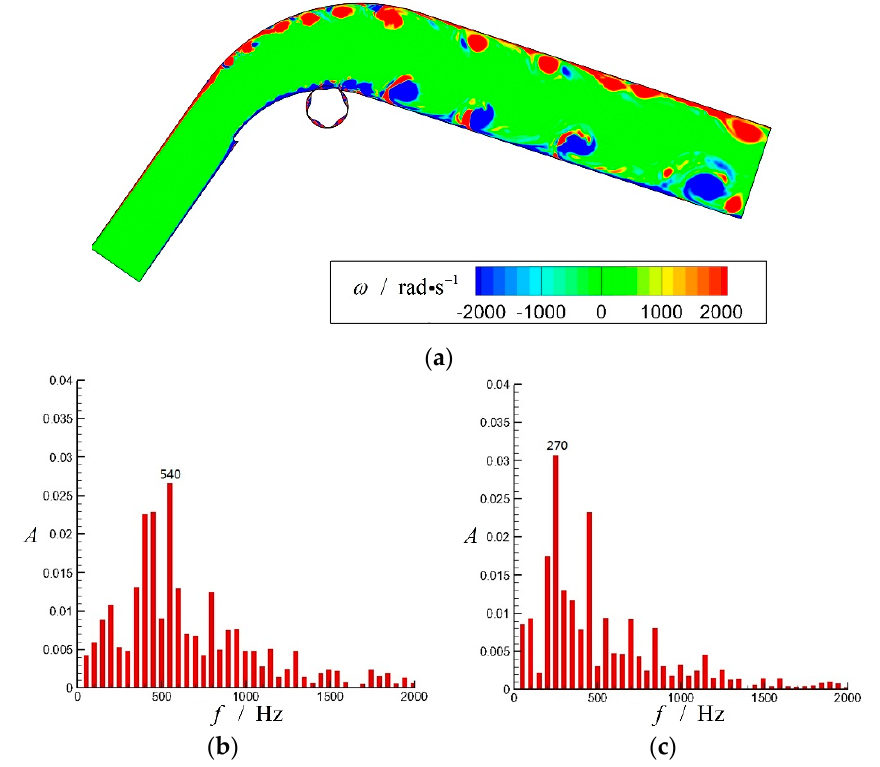
Figure 9. Numerical simulation of the diffuser with effective control ( (cid:101) V = 0.2, (cid:101) f = 1.5, and f TWW = 540 Hz): ( a ) Vorticity ( ω ) contour; ( b ) Velocity FFT of S1 ( A − f ); ( c ) Velocity FFT of S2 ( A − f